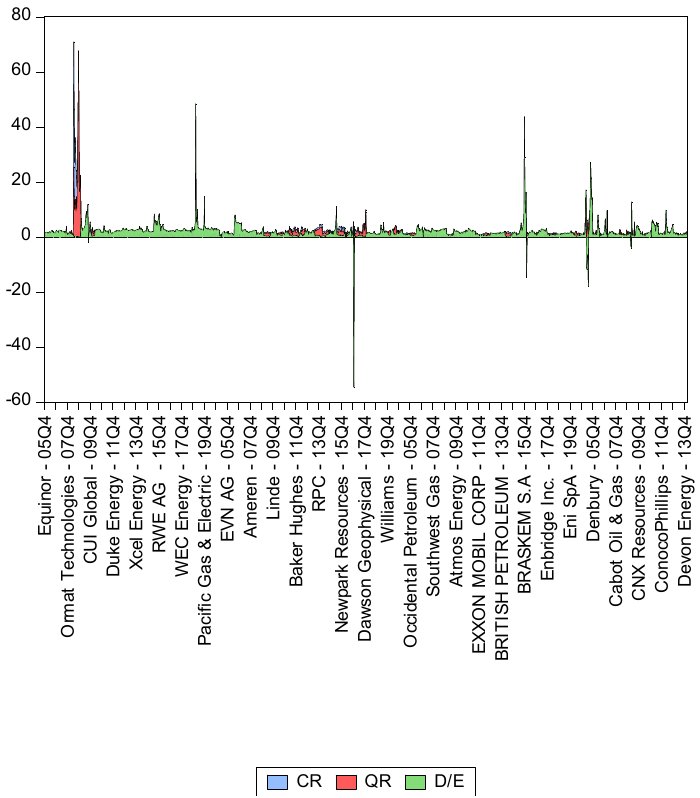
Figure 4. Evolution of equilibrium indicators for all energy companies in the sample.